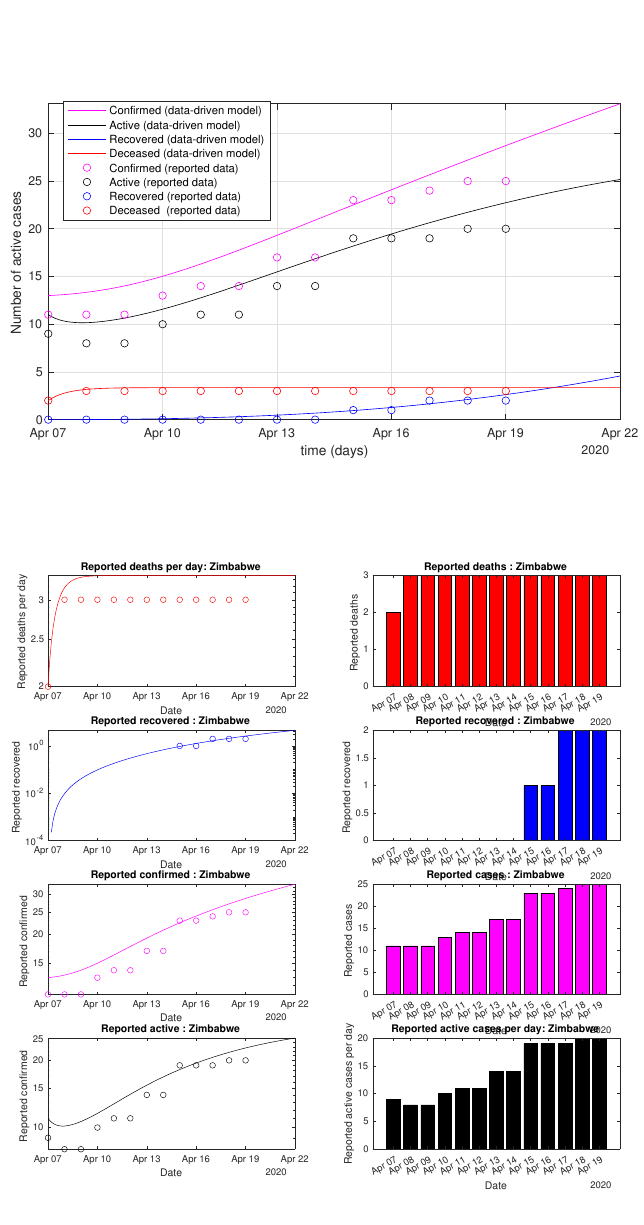
Figure 90. Zimbabwe: data vs.